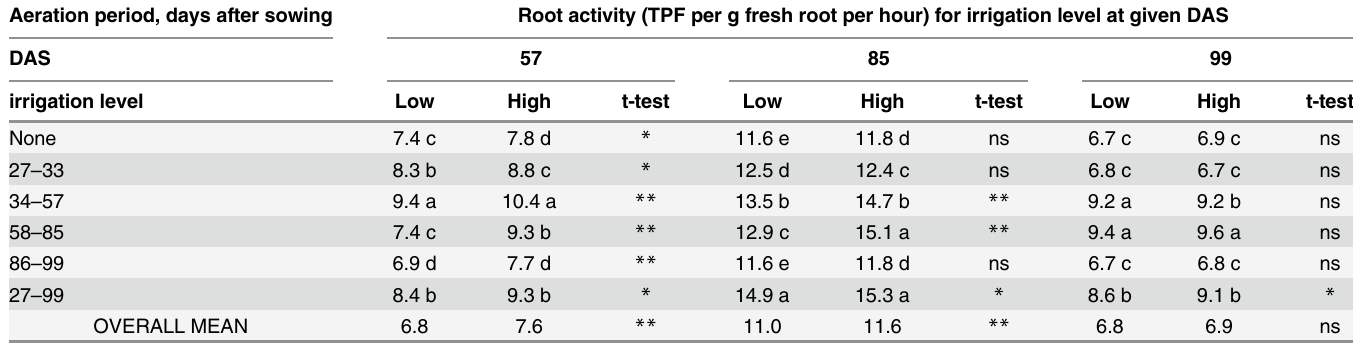
Table 3. Irrigation × post-infiltration aeration interaction on root activity (as mg triphenyl formazan per g fresh root per hour) of potted single tomato plants (n = 3) measured at 57, 85, and 99 days after sowing (DAS). Aeration treatments (i.e. none or 2.5 liter aeration applied during 5 different periods) at the low and high irrigation levels (i.e. subsurface drip-irrigation to maintain soil at 60 to 70% and 70 to 80% of volumetric field capacity). Aeration period, days after sowing Root activity (TPF per g fresh root per hour) for irrigation level at given DAS